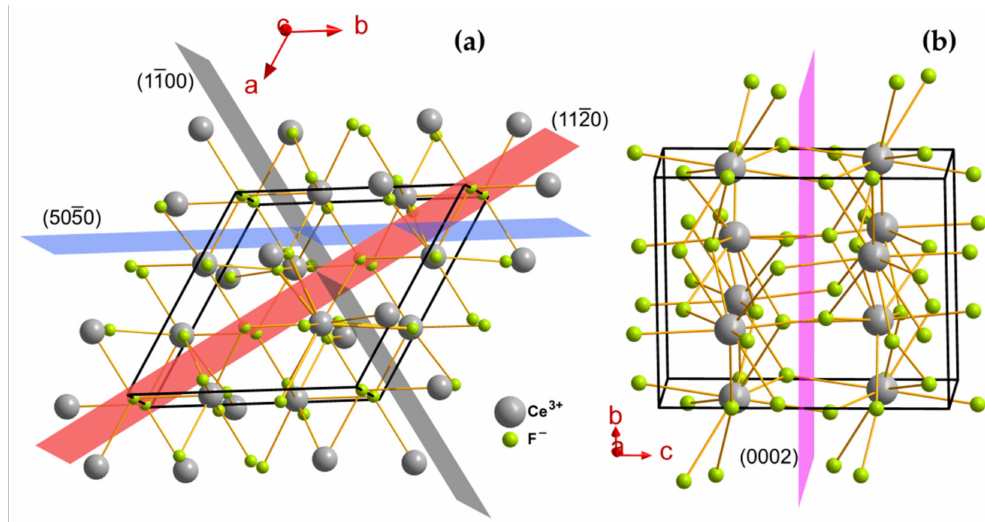
Figure 6. Schematic view of the CeF 3 crystal structure parallel ( a ) and perpendicular ( b ) to the c -axis. The positions of some characteristic crystallographic planes are demonstrated.